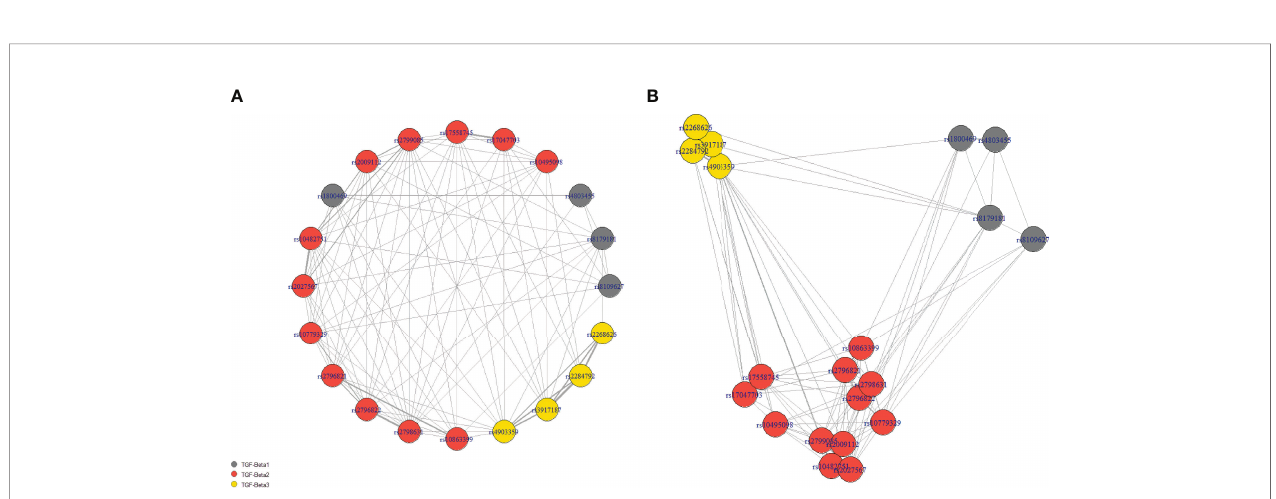
FIGURE 3 | The network of statistically signi fi cant disequilibrium. Panel (A) presents the nodes in the circle, while the location of nodes in panel (B) is dependent on the strength of the association (scaled r2 values). Grey lines show signi fi cant linkage disequilibrium between SNPs in the pairwise analysis. The weight of the line is calculated based on the r2 values. The length of connection corresponded inversely to the strength of